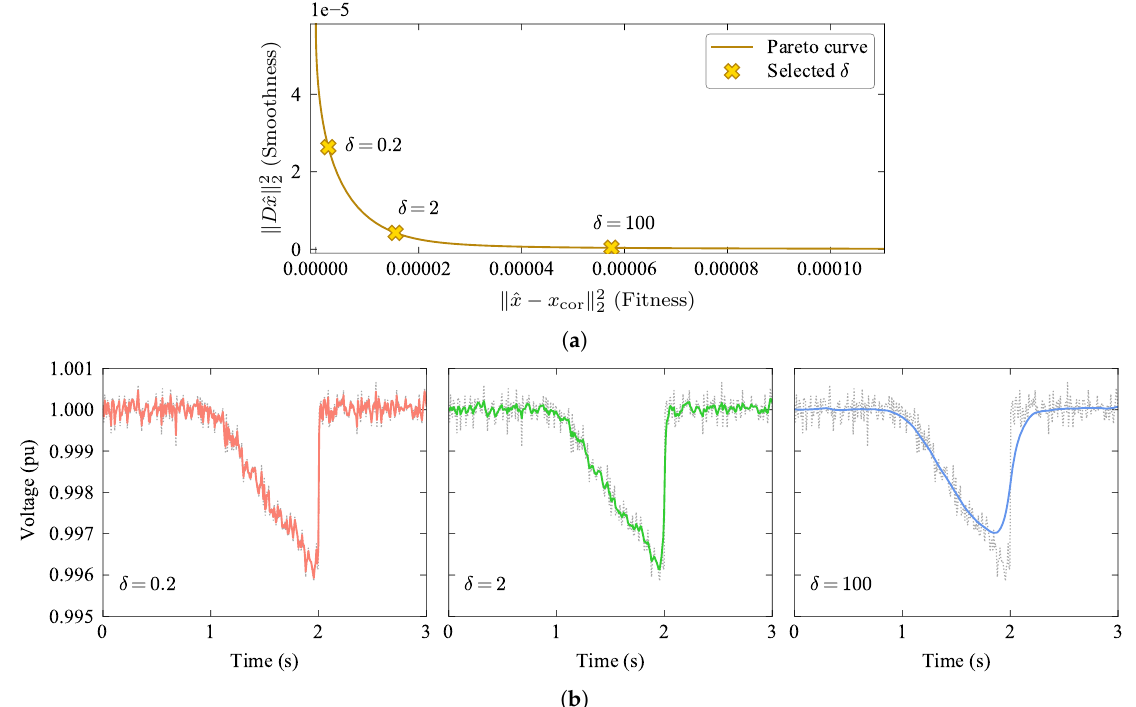
Figure 8. Results of filtering the corrupted synthetic signal 2 through quadratic smoothing. ( a ) Pareto curve. ( b ) Estimated signals representing under-filtering ( δ = 0.2), optimal filtering ( δ = 2) and over-filtering ( δ =